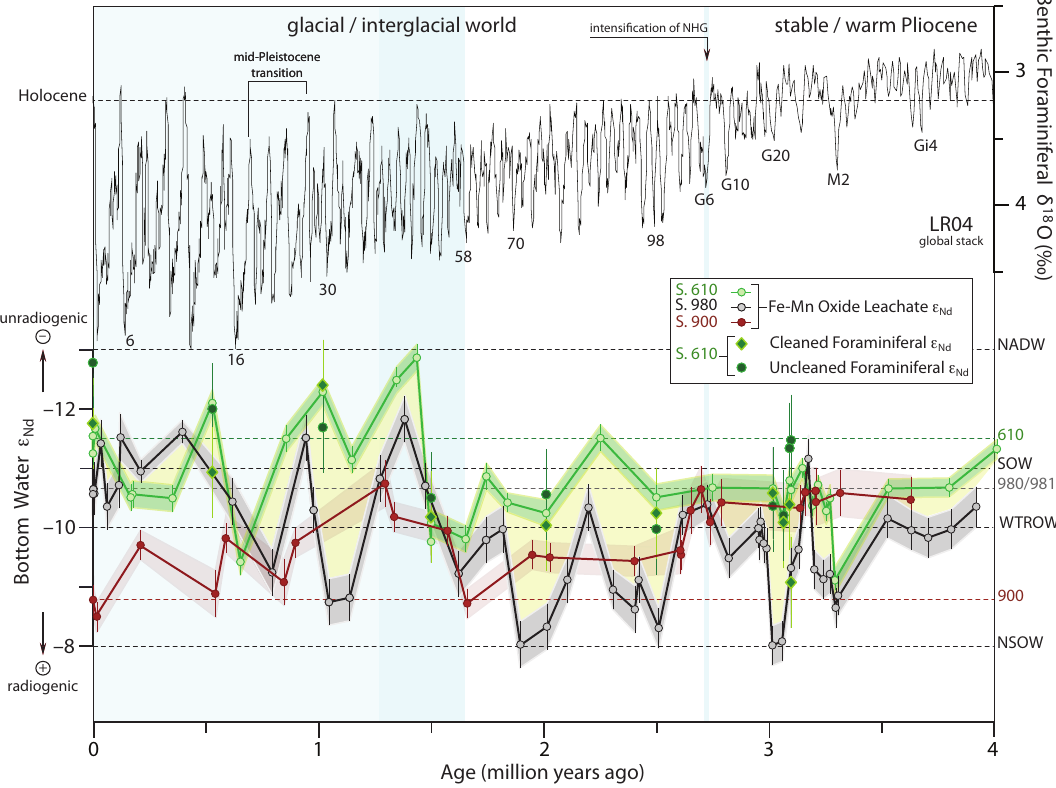
Figure 3. Changes in deep-water sources and water mass mixing in the northeast Atlantic during the past 4 million years as reflected by bottom-water ε Nd signatures at site 980/981 (black; 2170m water depth), site 610 (green; 2420m w.d.), and site 900 (brown; 5050m w.d.). Error bars and colored areas mark the 2 σ uncertainties of the measurements. The offset between ε Nd records at sites 980/981 and 610 is displayed in yellow. Horizontal dashed lines mark inferred modern bottom-water ε Nd signature at study sites and the northeast Atlantic from proximally water column measurements (Lacan and Jeandel, 2004a, b, 2005; Rickli et al., 2009) and near-core top leachates and foraminifera (Crocket et al., 2011; Piotrowski et al., 2013; this study). The numbers on the global benthic foraminiferal δ 18 O stack LR04 of Lisiecki and Raymo (2005) correspond to glacial marine isotope stages (MIS). NADW – North Atlantic deep water, SOW – Southern Ocean